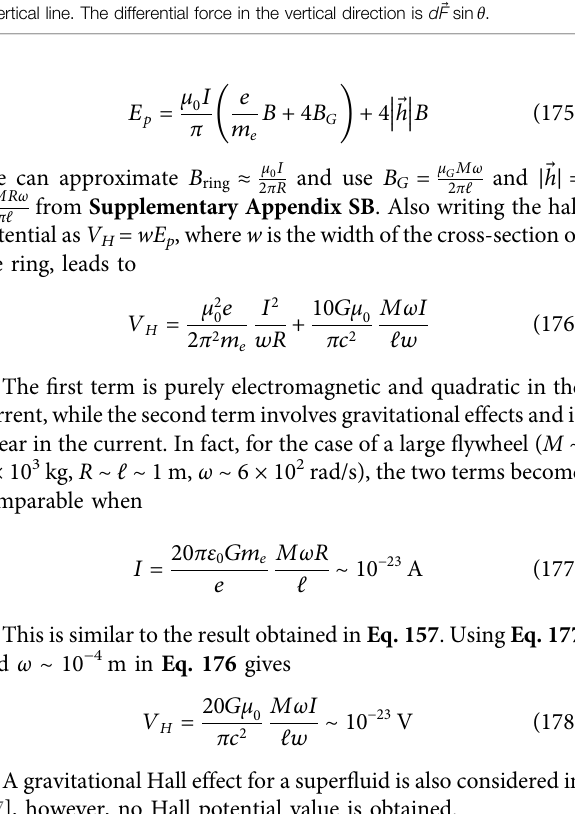
FIGURE 3 | A superconducting ring placed above a rotating mass cyldiner. At the location of the ring, (cid:2) B G makes an angle θ with respect to the vertical line. The differential force in the vertical direction is d (cid:2) F sin θ